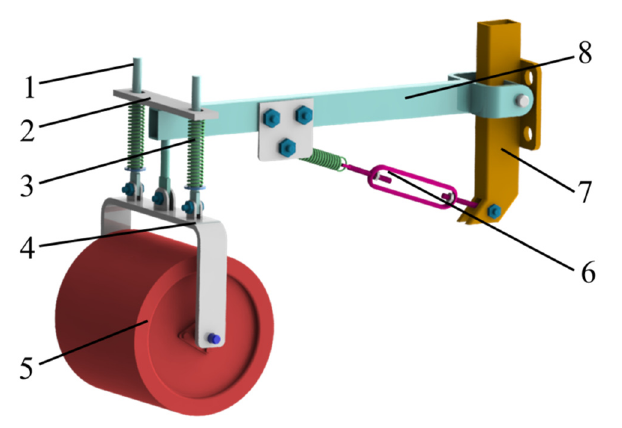
Figure 1. A structural diagram of the BPPD: (1) hanger rod, (2) limiting plate, (3) balance spring, (4) lower bracket, (5) press roller, (6) compression strength regulator, (7) front beam and (8) upper bracket.